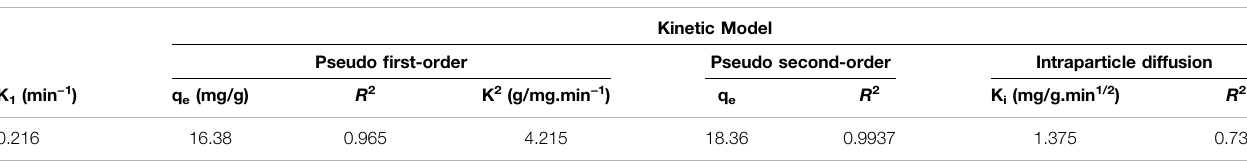
TABLE 3 | Adsorption kinetics of SMZ using 3D